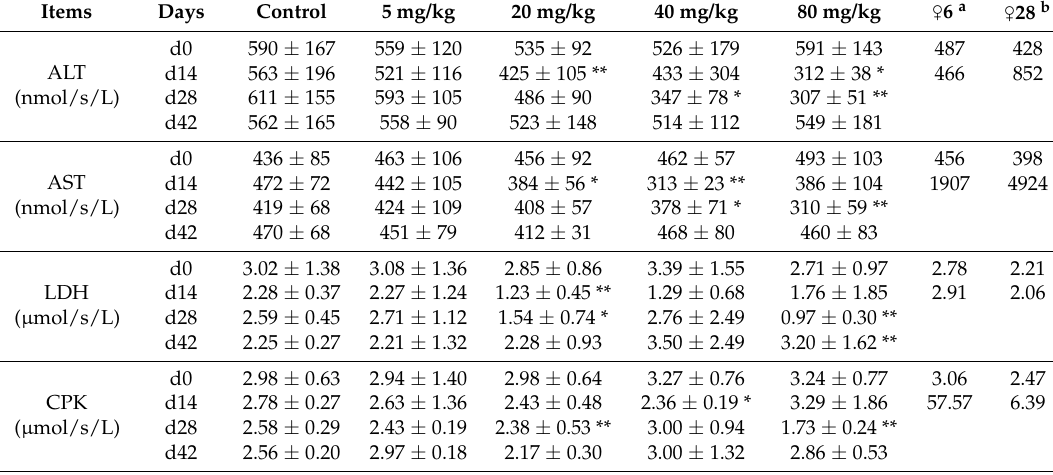
Table 3. Selected serum biochemistry parameters induced by HZ1006 in Beagle dogs following repeated dose administration during the study of subchronic toxicity (only significant results are